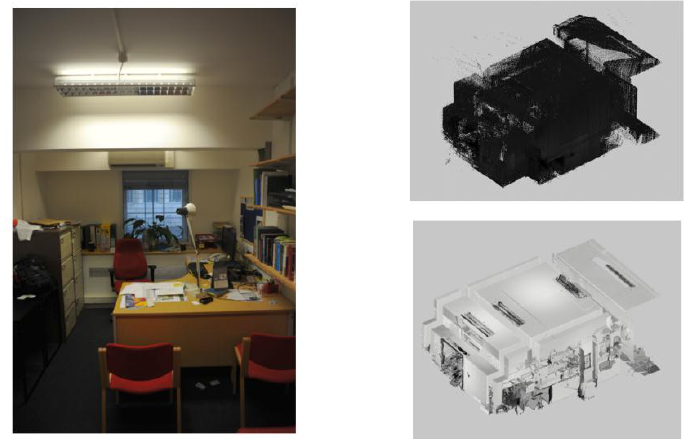
Figure 6. Image of office ( left ) and point cloud data collected with a Viametris Indoor Mobile Mapping System ( top right ) and Faro Focus 3D S ( bottom right